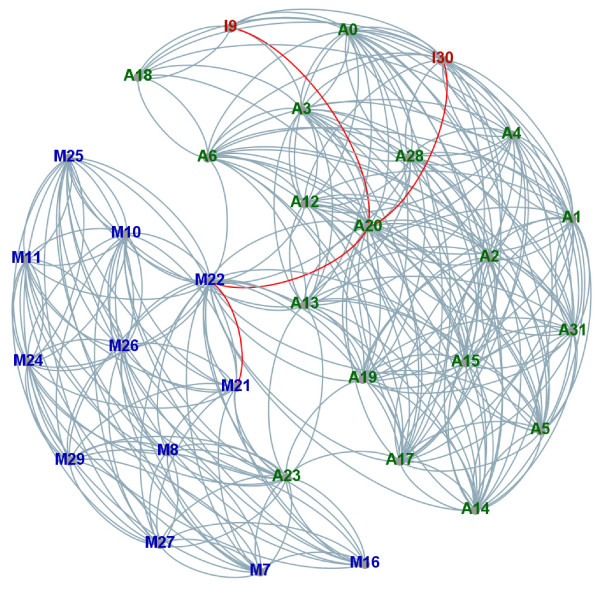
The true positive binding funnel. The true positive binding funnel for the vitamin D-binding protein/actin complex (1KXP [22]) generated with the SwarmDock Server [20] by docking unbound receptor/ligand pair included in Benchmark 4.0 [25]. The protein-protein conformational states are numbered from ID 0 to 31. The letter indicates the quality of solution in accordance to CAPRI [24] classification as: M – medium quality (blue), A – acceptable quality (green), I – incorrect solution (red). Favourable paths are marked in red. Figure created with Gephi [26] based on Example1/1KXP.gml file (Additional file 1). See text for more details.